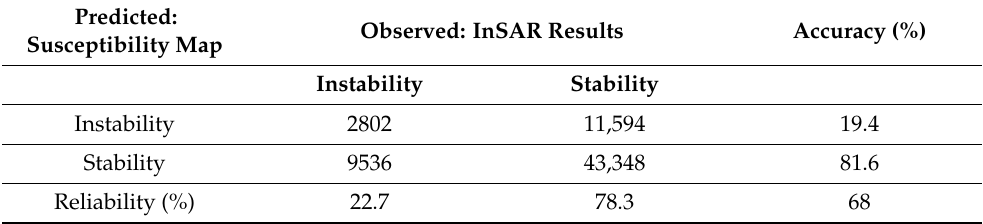
Table 4. Confusion matrix for assessing the deterministic results accuracy relative to the InSAR- derived ground